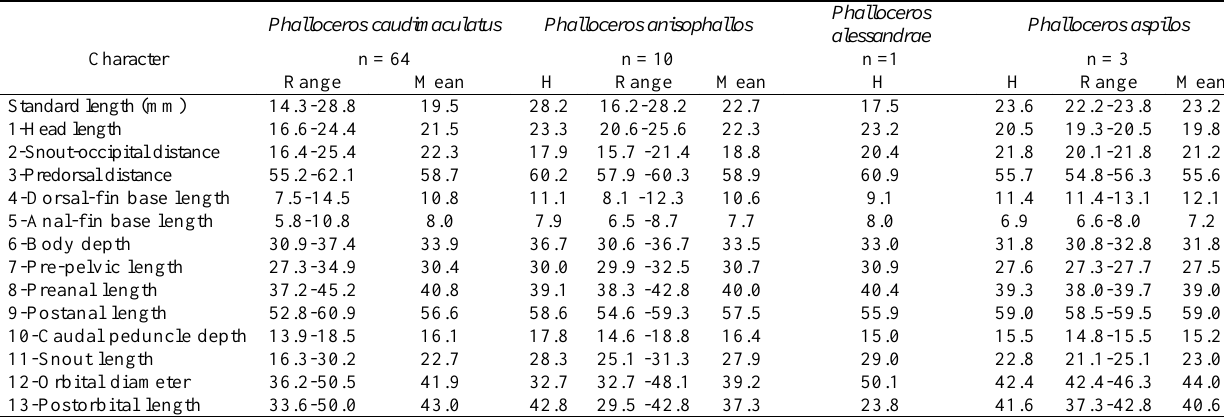
Table 6. Descriptive morphometrics of male specimens of Phalloceros Phalloceros caudimaculatus , P . anisophallos , P . alessandrae , and P . aspilos . Measurements 1-10 are percents of standard length and measurements 11-13 are percents of head length. H =